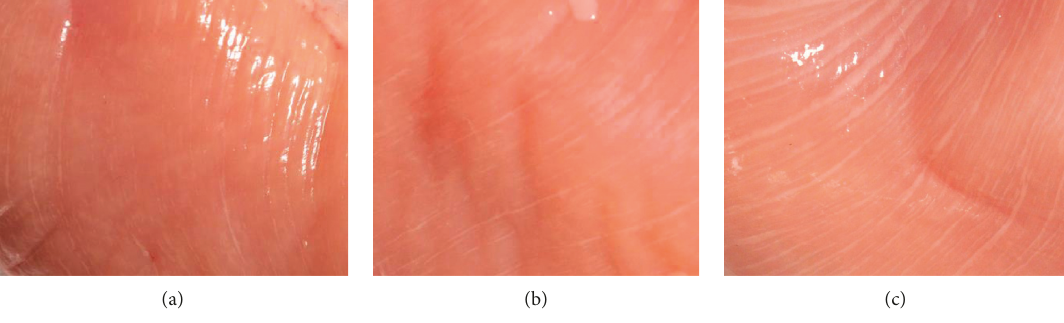
Figure 1: White striping: 0—no WS (a), 1—medium WS (b), and 2—severe WS (c). Table 2: Meat quality parameters in breast muscle of chickens fed based on different Met sources and concentrations.